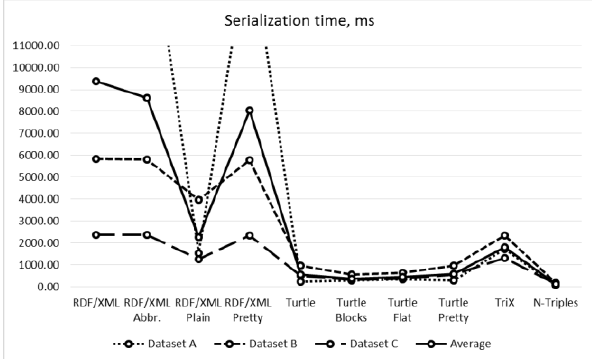
Fig. 9. Serialization time results for all syntaxes.